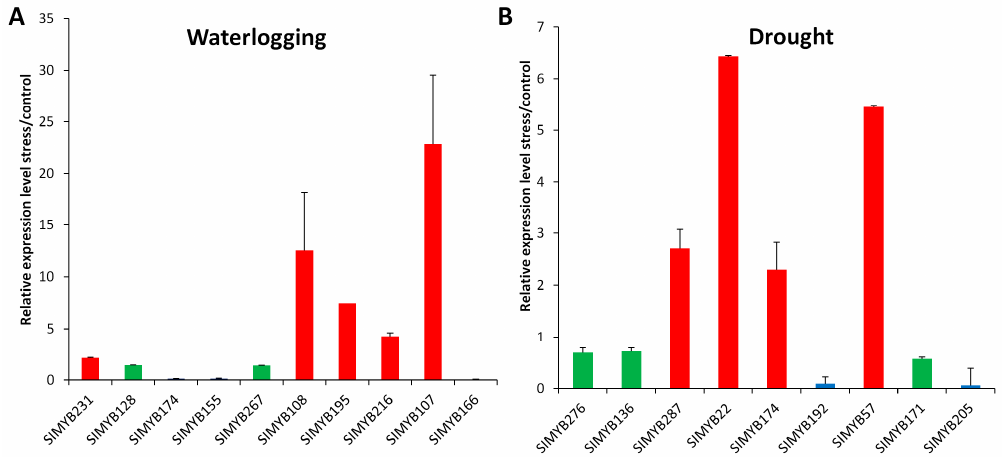
Figure 6. MYB gene induction rates in sesame roots during abiotic stress treatments. ( A ) 9 h of waterlogging; ( B ) 3 days of drought. Transcripts abundance was quantified through qRT-PCR and the experimental values were normalized using sesame Actin as reference gene. The histograms represent the relative expression values of induction rates (stress/control). The green bars represent the no significantly regulated genes, the red bars represent the genes significantly up-regulated (induction rate > 2) and the blue bars represent the significantly down-regulated genes (induction rate < 2).